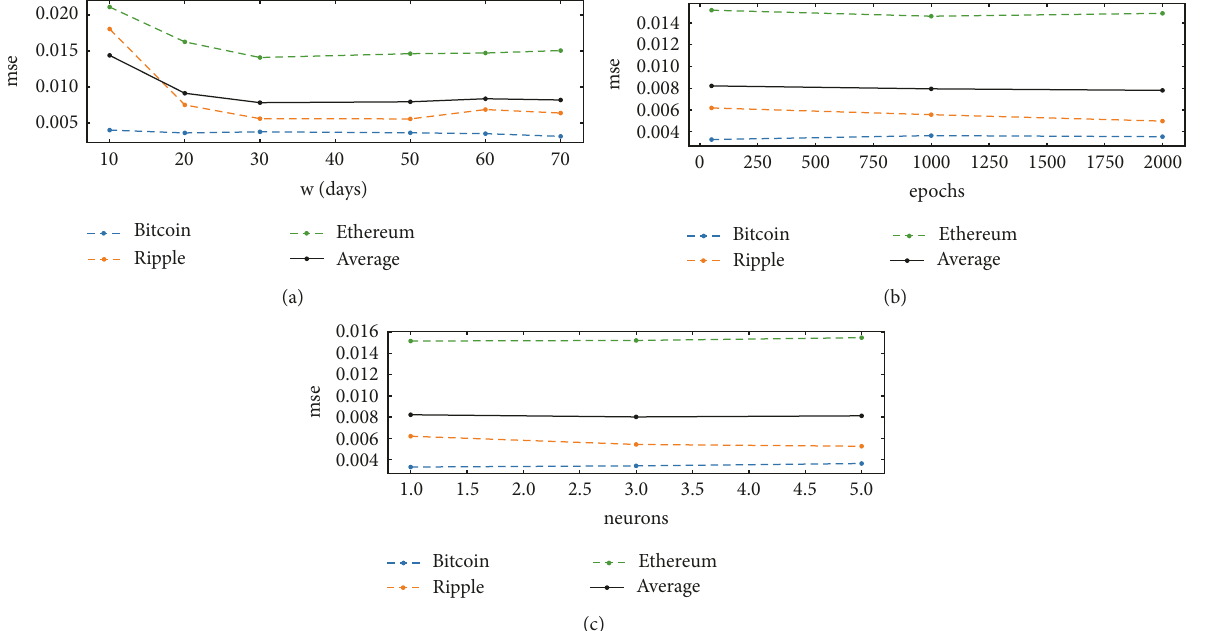
Figure 11: Method 3: parameters optimisation. The median squared error of the ROI as a function of the window size (a), the number of epochs (b), and the number of neurons (c). Results are shown considering prices in